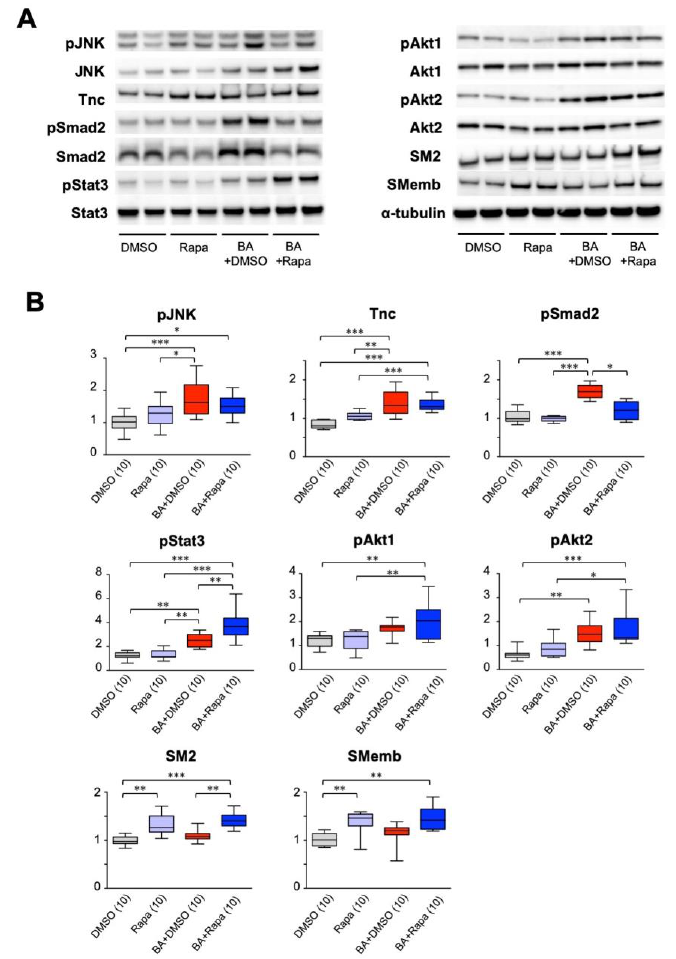
Figure 4. Effect of rapamycin on cellular signaling in AD. Effect of rapamycin on protein expression in the AD model with or without 3 days of BAPN + AngII challenge. Mice were treated with vehicle (DMSO) or rapamycin without or during the BAPN + AngII challenge (BA). Representative images for Western blotting ( A ) and quantitative analysis of the selected proteins ( B ) are shown. The figures in parentheses indicate the numbers of independent observations. * p < 0.05, ** p < 0.01, *** p < 0.001. Among the multiple experimental groups, all comparisons between two groups were tested and for simplicity only those with statistically significant differences are indicated.